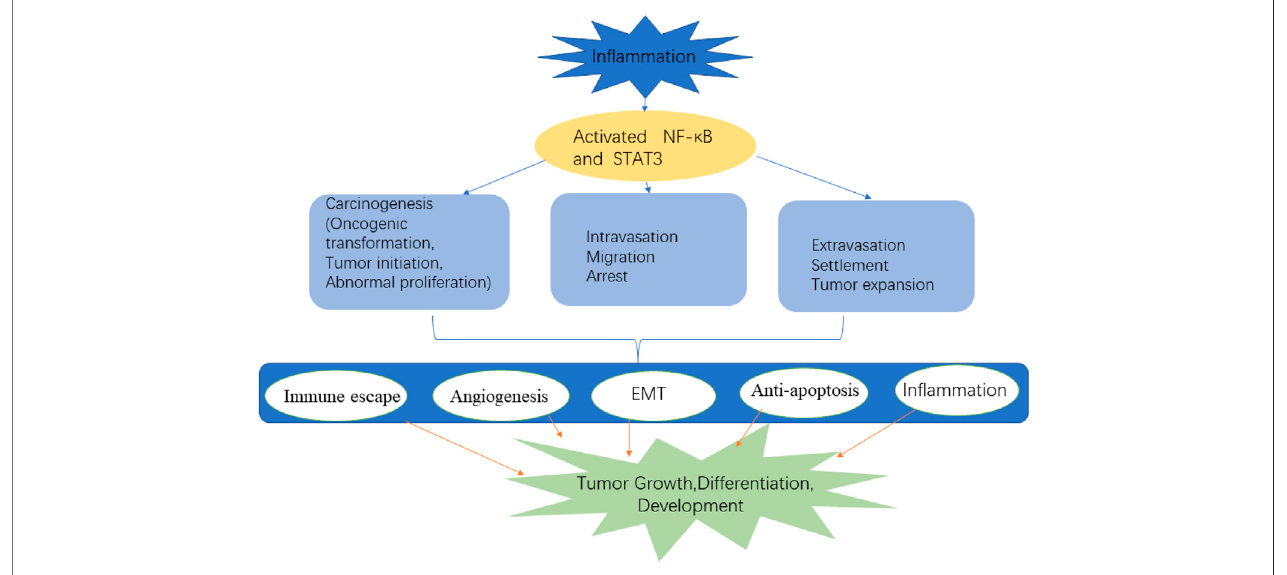
FIGURE 4 | The multifaceted role of NF- κ B and STAT3 in